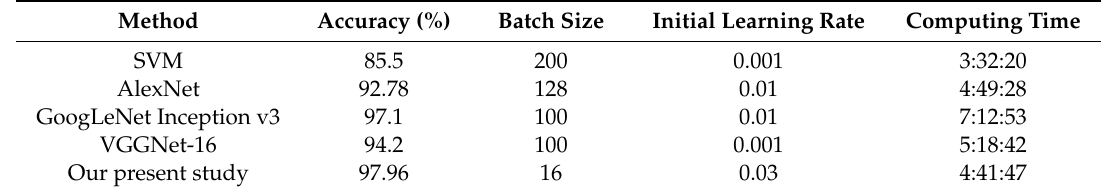
Table 6. Recognition performance and related parameters.